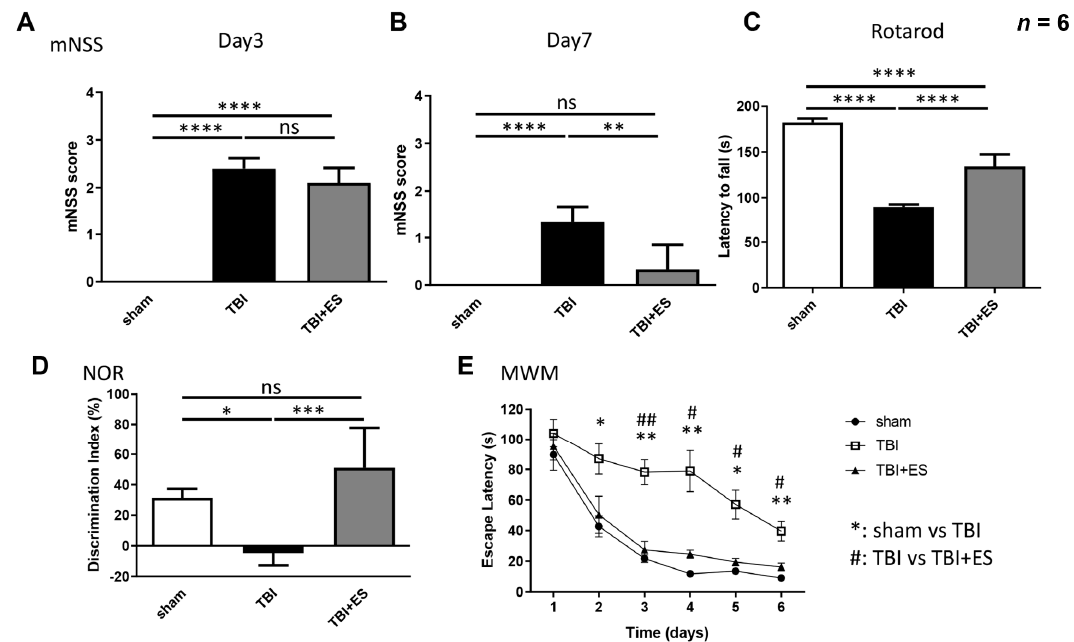
Figure 2. The neurological evaluation showed that CES improves functional recovery after TBI. ( A ) The modified neurological severity score (mNSS) evaluated on the third day after TBI showed no difference in terms of neurological severity between the TBI group (TBI + sham stimulation) and the TBI + ES group (TBI + cortical electrical stimulation). ( B ) On the seventh day after TBI, there was a significant improvement in mNSS in the TBI + ES group compared to the TBI group ( p < 0.005). ( C ) The rotarod test showed a significantly prolonged latency to fall in the TBI + ES group ( p < 0.0001). ( D ) The novel object recognition (NOR) test showed a significantly improved decimation index in the TBI + ES group ( p < 0.001), indicating improved short-term memory by CES after TBI. ( E ) The Morris water maze (MWM) task showed that the escape latency in the sham group was significantly shorter than that in the TBI group from day 2 to day 5. The escape latency was significantly shorter in the TBI + ES group than in the TBI group, and there was no difference between the sham and the TBI + ES groups. Values are expressed as the mean ± SEM. **** p < 0.0001, *** p < 0.001, ** p < 0.005, * p < 0.05, ## p < 0.005, # p < 0.05.